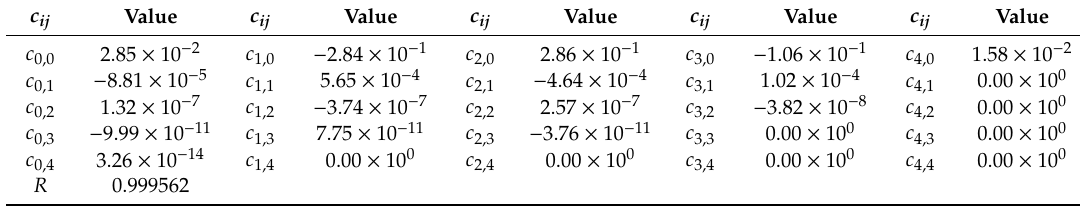
Table 5. Material constants c ij of the polynomial α ( ε , T ) (9).